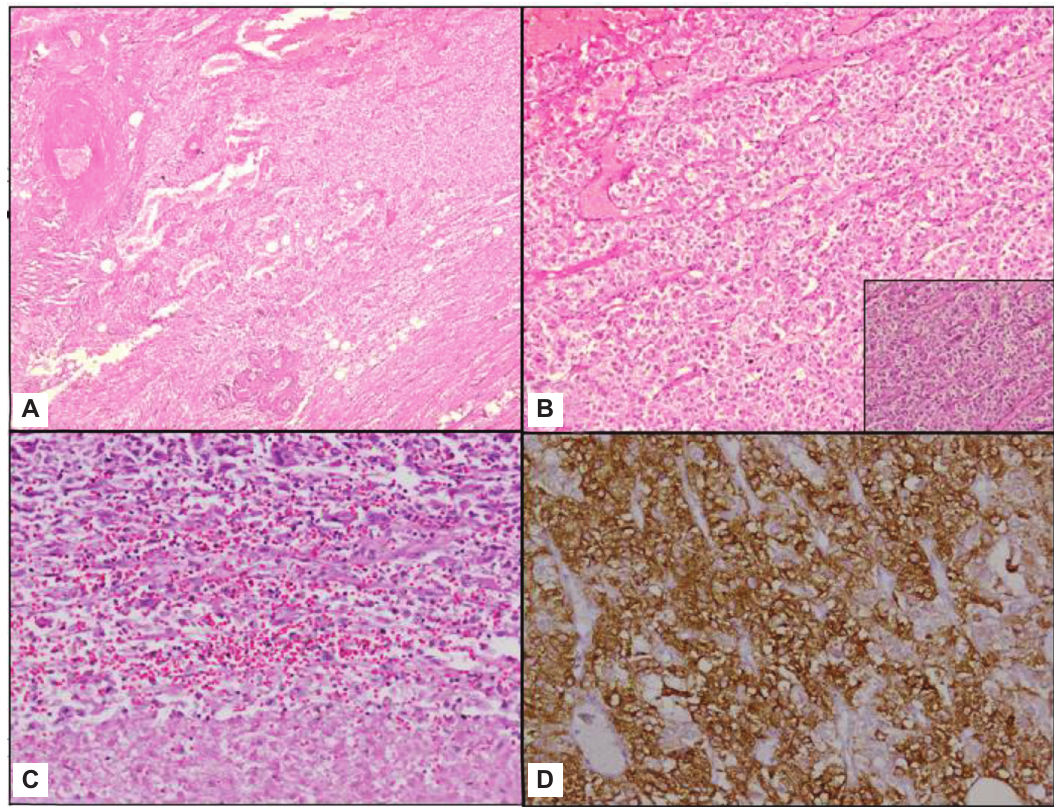
Figure 4: Histopathological findings of epithelioid angiomyolipoma. (A) Section from the mass shows a tumor predominantly composed of polygonal cells with focally present thick vessels and interspersed fat cells (hematoxylin and eosin × 40). (B) The tumor cells are predominantly epithelioid (polygonal), arranged in a nesting pattern (hematoxylin and eosin × 100). Inset com- prised a high magnification image of tumor where tumor cells show moderate to abundant and clear to granular eosinophilic cytoplasm with distinct cytoplasmic boundries (hematoxylin and eosin × 200). (C) The tumor also shows large areas of necrosis. The surrounding tumor cells show moderate nuclear atypia and prominent nucleoli (hematoxylin and eosin × 200). (D) Tumor cells are immunopositive for HMB45 (×